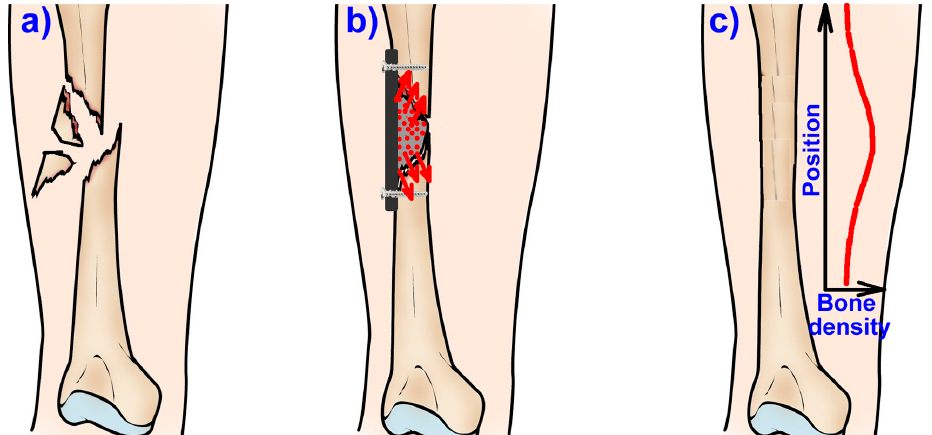
Figure 8. Schematic representation of bone grafting, healing and bone density distribution: (a) fracture; (b) bone grafting and healing ; (c) bone density distribution .